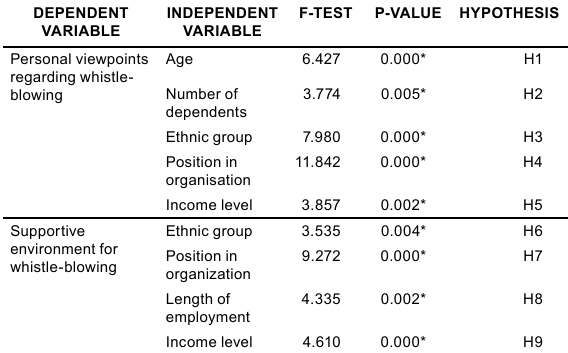
Table 6 Analysis of variance results for the variables